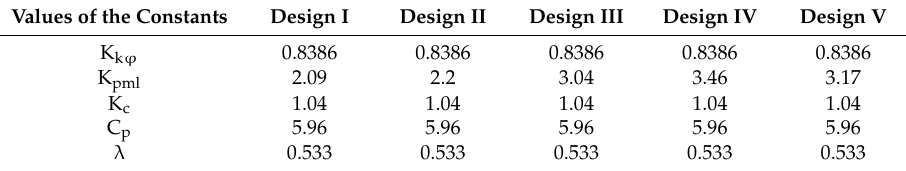
Table 6. Some of constant values of the AFPM motor counted by